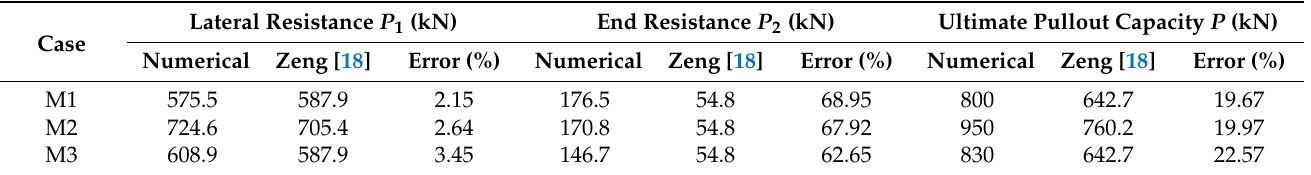
Table 5. Comparison between numerical solutions and theoretical solutions based on